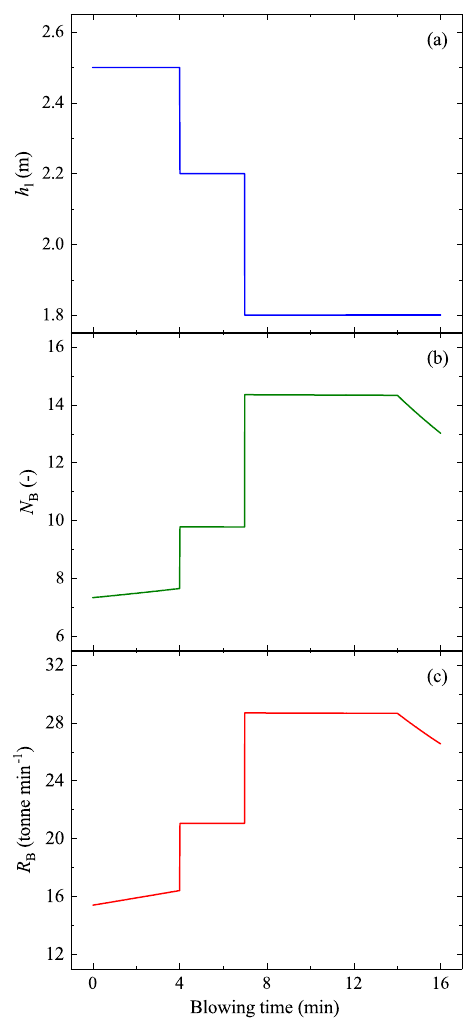
Figure 7. Assessed factors used in the model calculation: ( a ) lance height ( h l ) [27,32], ( b ) blowing number ( N B ), and ( c ) the droplet generation rate ( R B ) as a function of the oxygen blowing time. (color